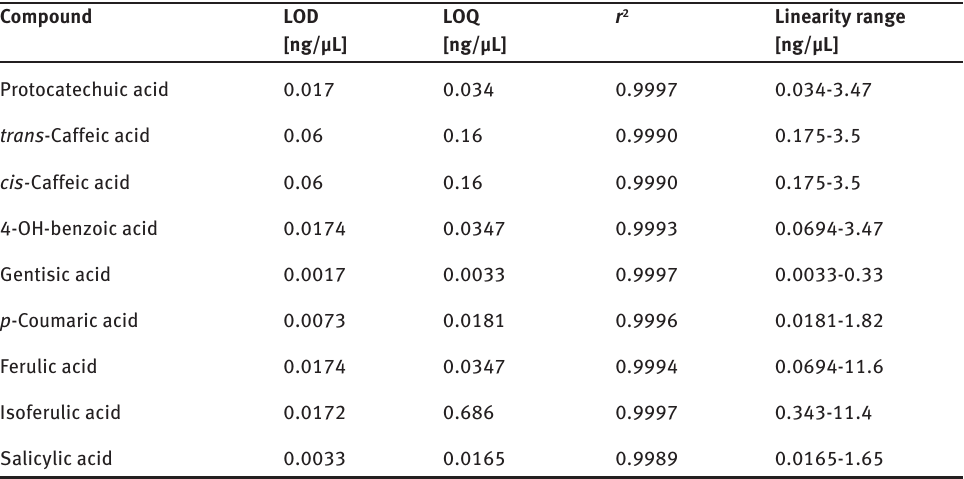
Table 6: Limit of detection (LOD), limit of quantification (LOQ) and calibration curve parameters for all